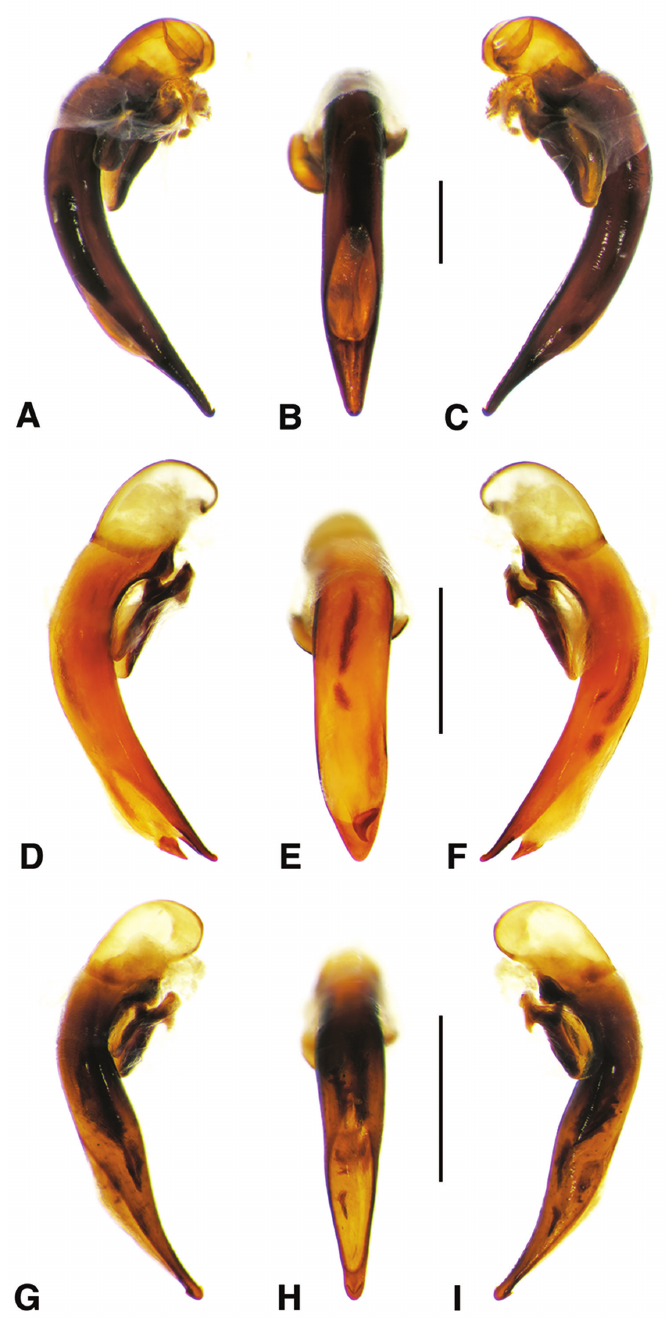
Figure 2. Digital images of male genitalia. A, D, G right lateral aspect B, E, H dorsal aspect C, F, I left lateral aspect A–C Neoaulacoryssus cupripennis (Gory) D–F Paraulacoryssus puertoricensis (Mutchler) G–I Athrostictus paganus (Dejean). Scale bars 1